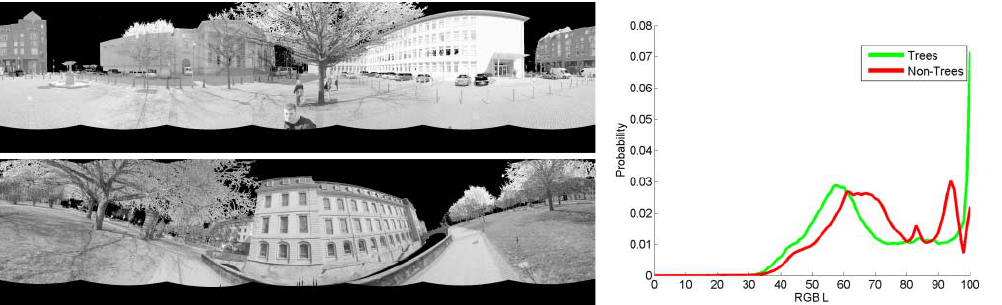
Figure 12. L values of the Luv representation of the color channel, and their tree/non-tree